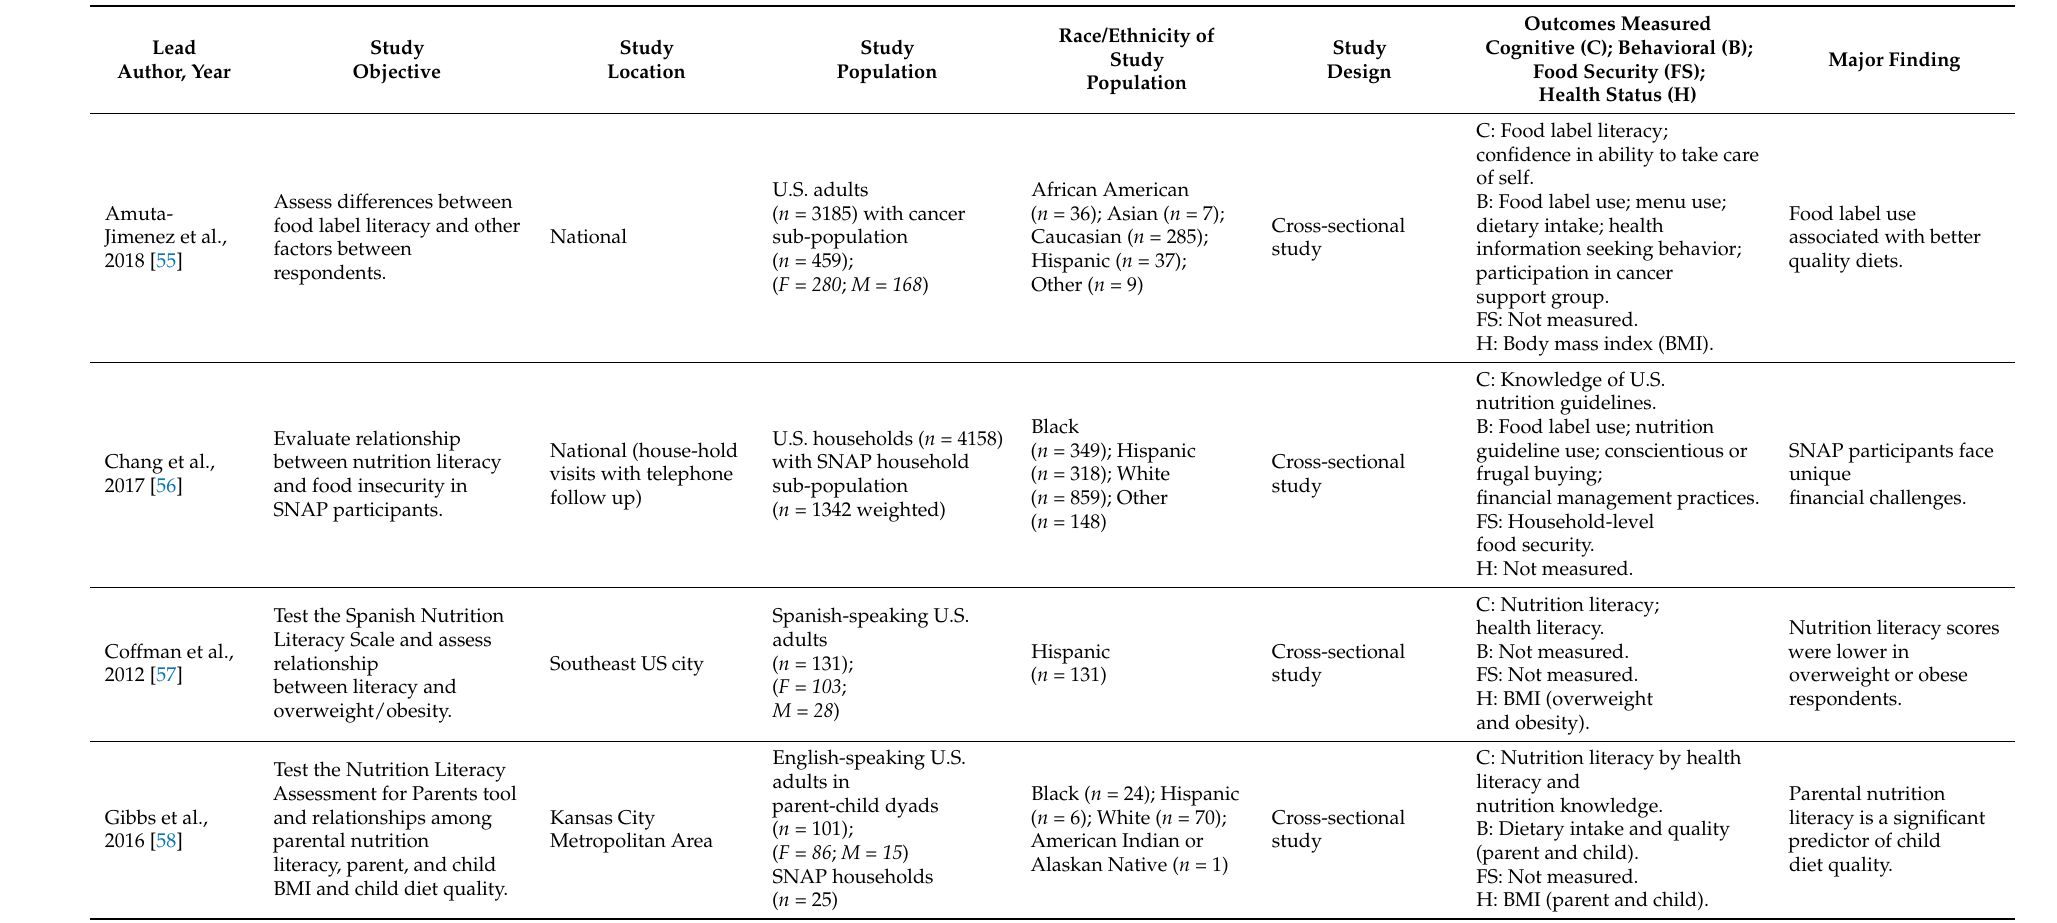
Table 2. Studies that evaluated the food and/or nutrition literacy of U.S. adults, including SNAP adults,